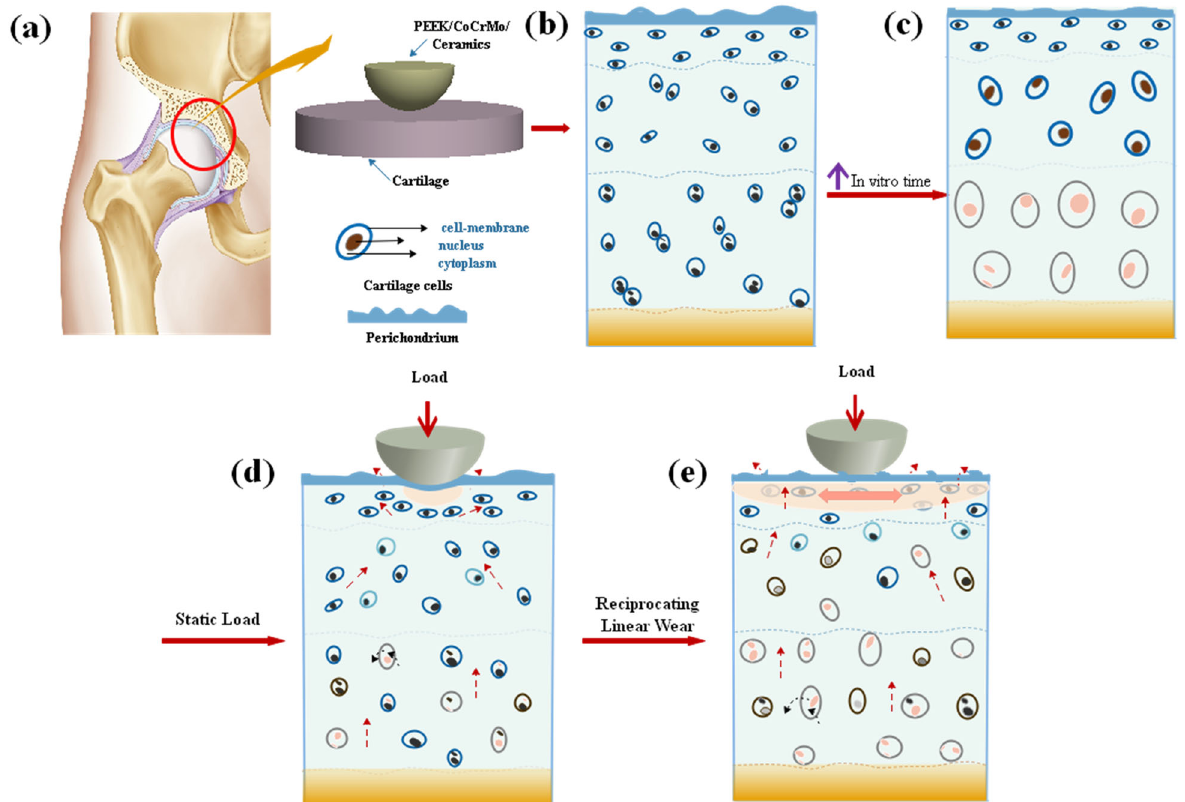
Fig. 14 The cartilage injury